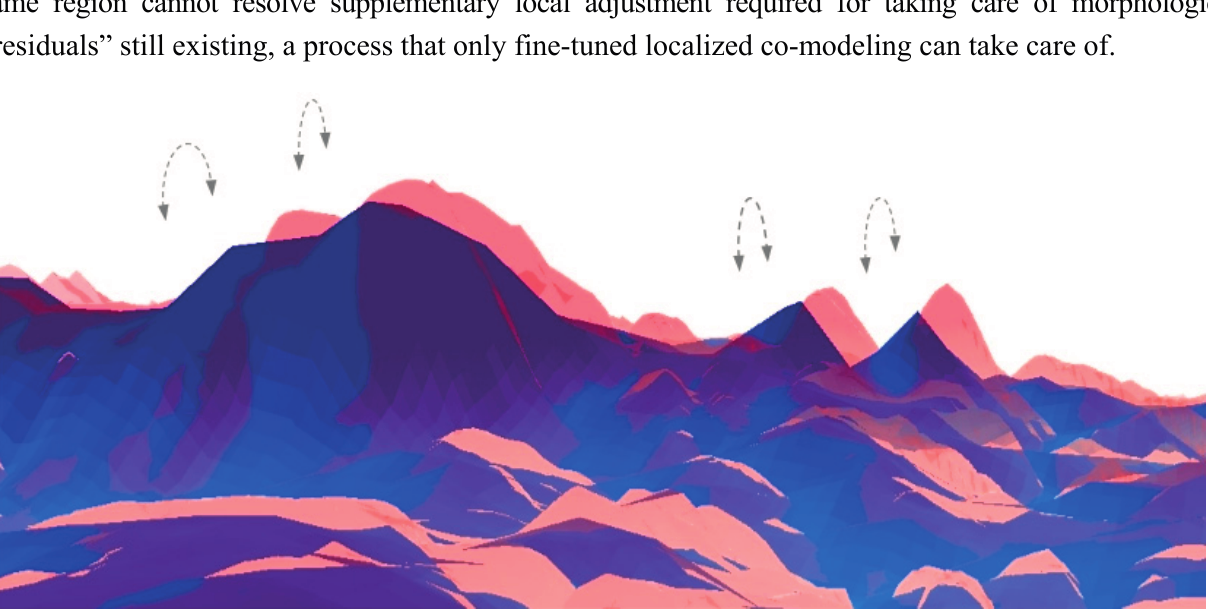
Figure 1. Direct datum-transformation of two different Digital Terrain Model (DTM) databases showing topographic and morphologic inconsistencies, depicted by arrows, which can be resolved only by rigorous local